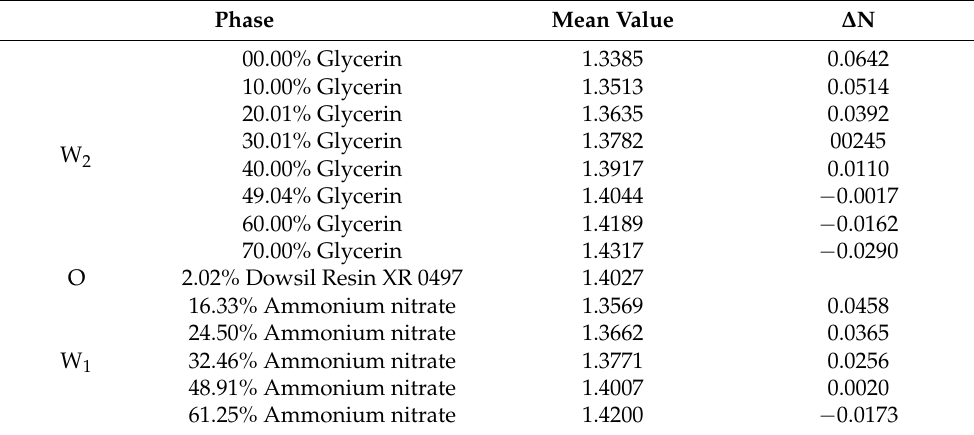
Table 1. Summary of the refractive indices for each phase. Each mean value is based on three measurements. Each set of measurements has a standard deviation of less than 0.0001. ∆ N is the difference between the refractive index of the oil phase compared to the water